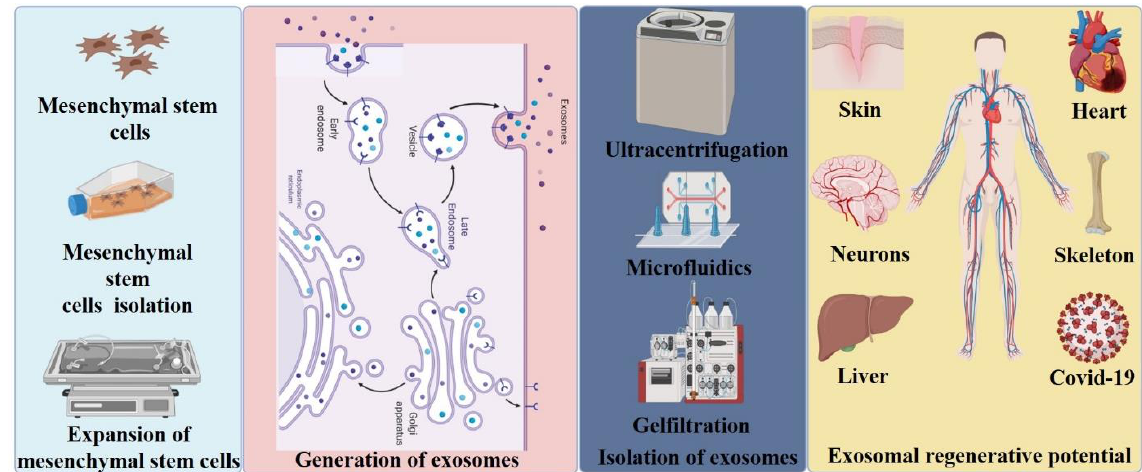
Figure 3. MSC-derived exosome methodology. Graphical representation of isolation of MSCs, exosome biogenesis, isolation of exosomes. and therapeutic applications of exosomes in regenerative medicine.